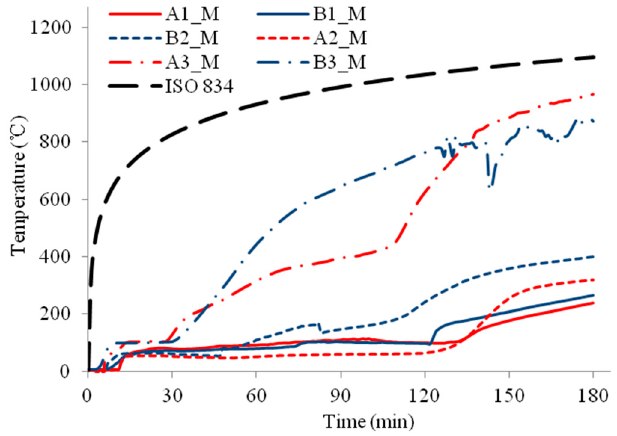
Figure 12. Temperature profiles at the top section for HSS-C2.